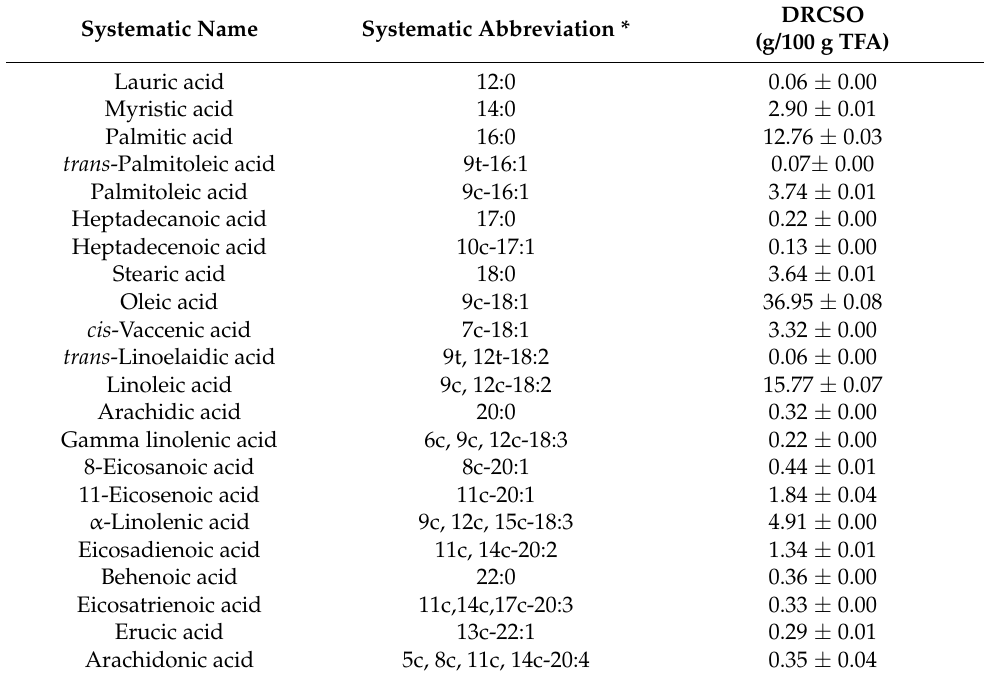
Table 2. Fatty acid (FA) composition and quantification of deodorized commercial refined salmon oil